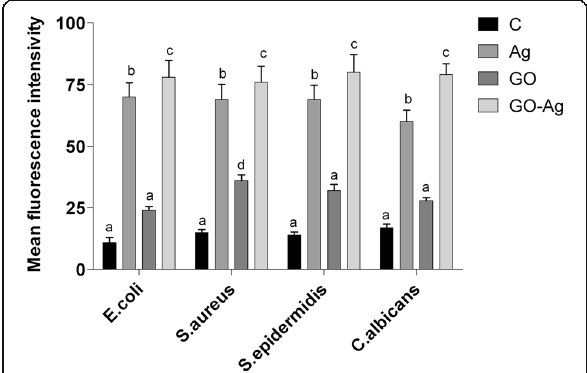
Fig. 13 Effect of foils coated with nanomaterials on the production of reactive oxygen species. E . coli , S . aureus , S . epidermidis , and C . albicans were cultured on foils coated with Ag-NPs, GO, and GO-Ag at 37 °C for 24 h. Production of reactive oxygen species was assessed with DCFDA, Cellular Reactive Oxygen Species Detection Assay Kit. C control group (foil without nanoparticles), Ag foil coated with silver nanoparticles, GO foil coated with graphene oxide, GO-Ag foil coated with composite of graphene oxide and silver nanoparticles. Note: The columns with different letters (a – d) indicate significant differences between the concentrations ( P = 0.000); error bars are standard